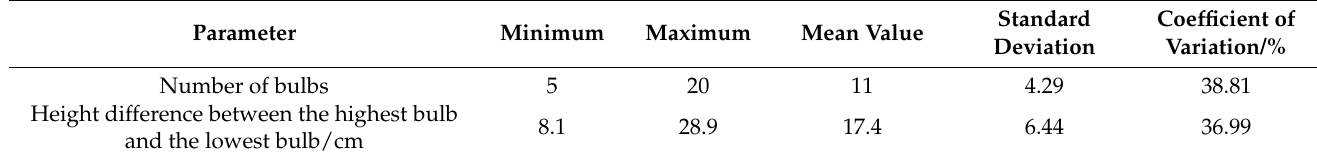
Table 2. Safflower parameter values.